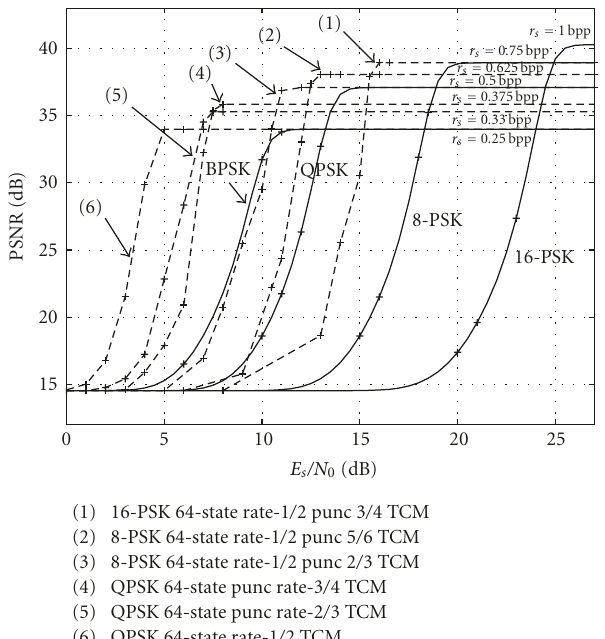
Figure 4: PSNR versus E s /N 0 performance of our adaptive TCM system for transmitting the SPIHT compressed 512 age using 65,536 symbols. Numbers next to the performance ceil- ings are the source coding rates r s = R 0 r c k , with R 0 = 0 . 25 and M = 2 k being the constellation size.